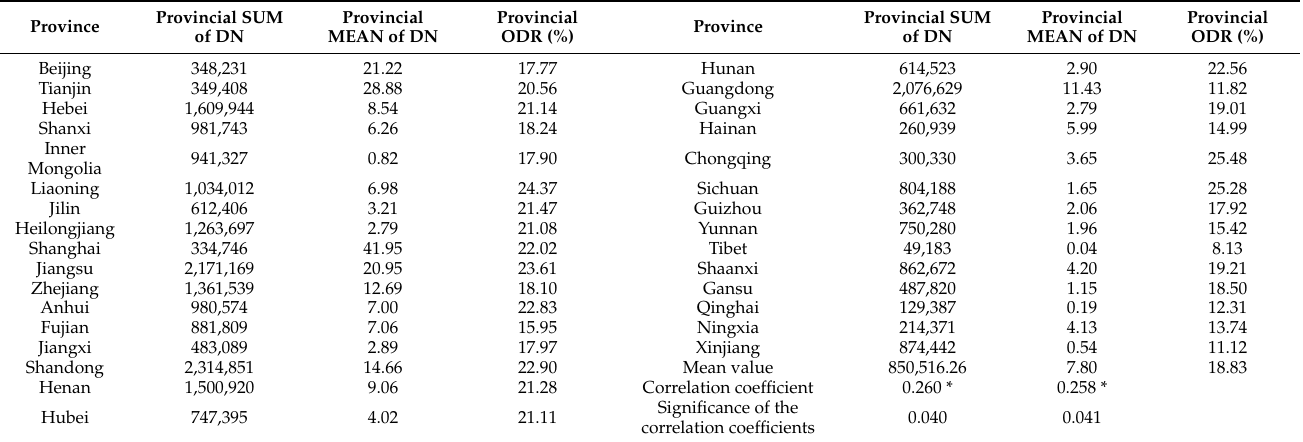
Table A1. Pearson correlations between ODR and nighttime light variables.